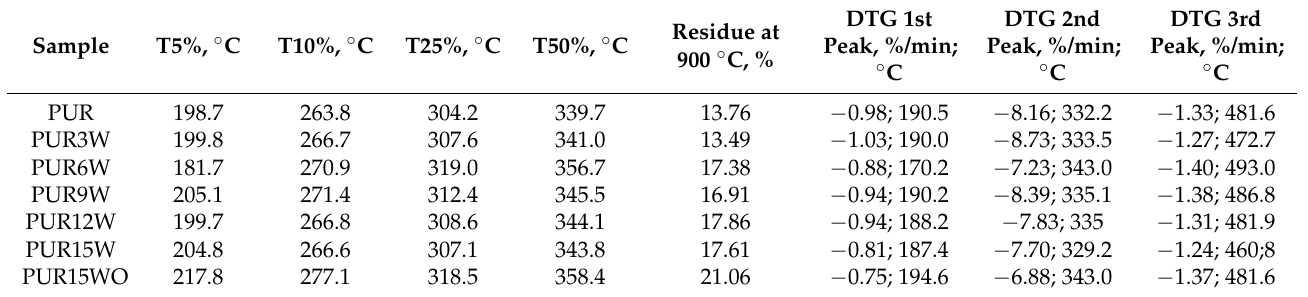
Figure 11. Representative heat release rate curves of PU foams modified with vermiculite. Table 6. Cone calorimeter test results of the tested foams. Sample